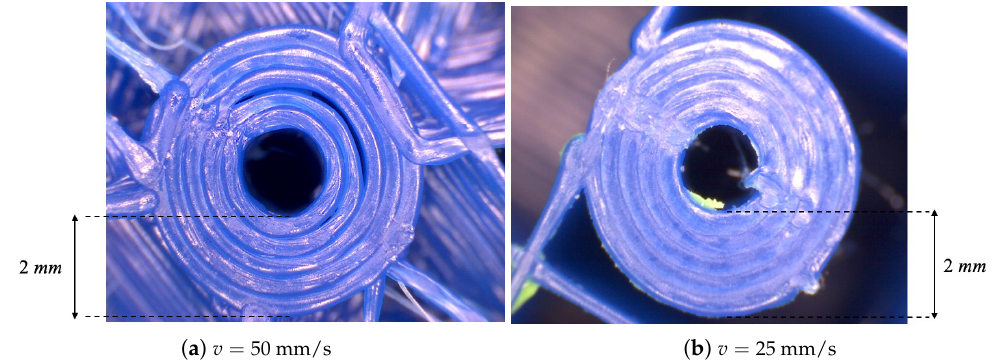
Figure 6. Influence of printing speed on the shells quality and adhesivity around a